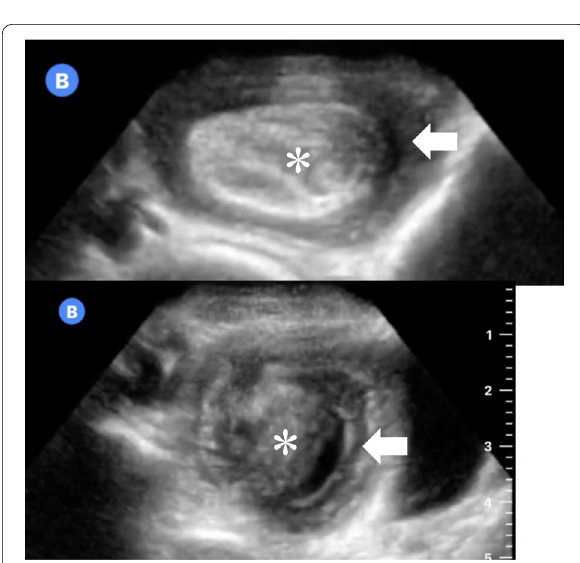
Fig. 2 Abdominal point-of-care ultrasound of a previously healthy 3-year-old male with abdominal pain, nausea, and vomiting diagnosed with intussusception, confirmed and treated by air contrast enema. a reveals a stereotypical “target sign”, hyperechoic compressed inner loop of bowel (*) telescoping within a hypoechoic, edematous outer loop (arrow). b reveals the target sign in another cross sectional plane, with multiple layers of telescoping bowel